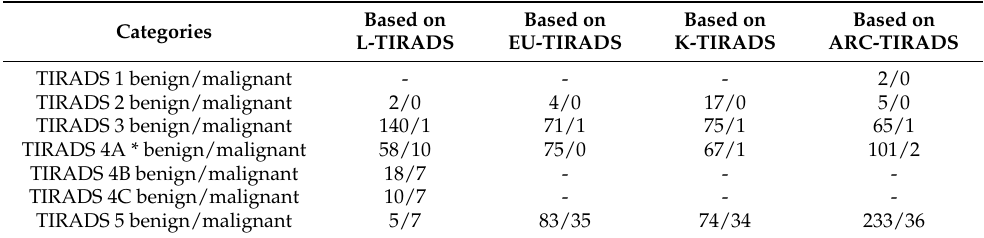
Table 5. Comparison between L-TIRADS, EU-TIRADS, K-TIRADS, and ACR-TIRADS categories.